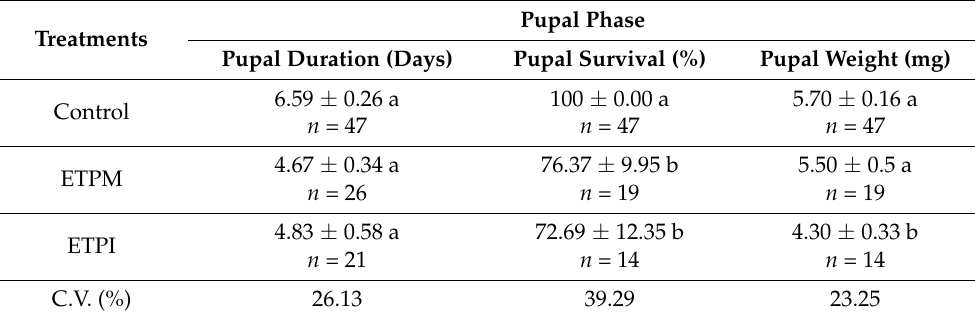
Table 2. Duration, survival and pupal weight ( ± standard error) of Plutella xylostella exposed in plastic tunnels to different treatments with 10% Tradescantia pallida aqueous extract (Temp: 23 ± 8 ◦ C, RH: 53 ± 10%, photophase: 13 h ± 36 min).